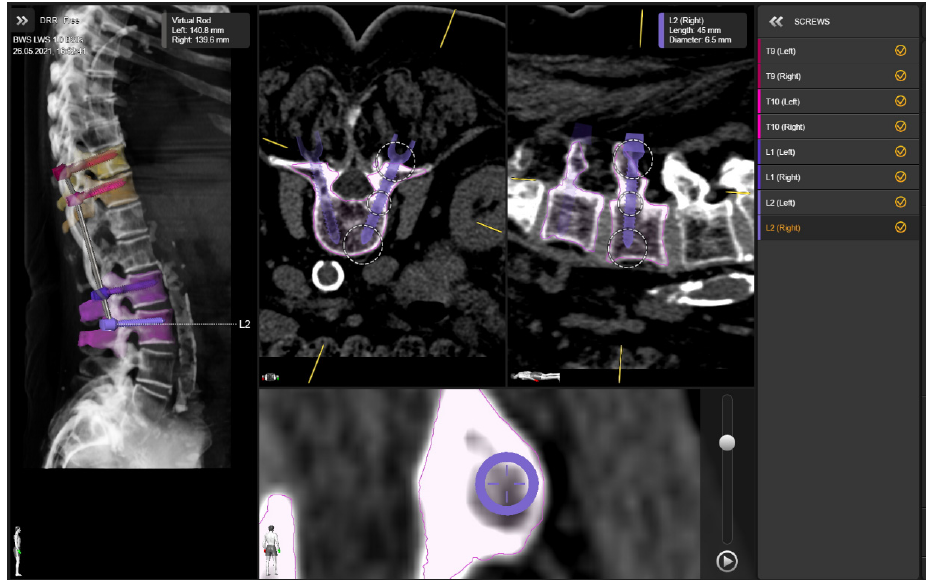
Figure 1. Preoperative screw planning using Screw planning application (BrainLab, Munich, Germany). The intraoperative setting with iCT has been described elsewhere [14]. The patient was placed on a mobile, radiolucent carbon-fiber surgical table (TruSystem ® 7500, Trumpf Medical Ditzinger, Germany) for spinal applications, connected to the CT scanner (AIRO ® , Brainlab, Munich, Germany). Surgery was performed in the scanning position with anes- thesia cables and lines routed through the gantry. Cirq ® was attached and draped on the left side of the operating table on a metal holder. (Figure 2.)